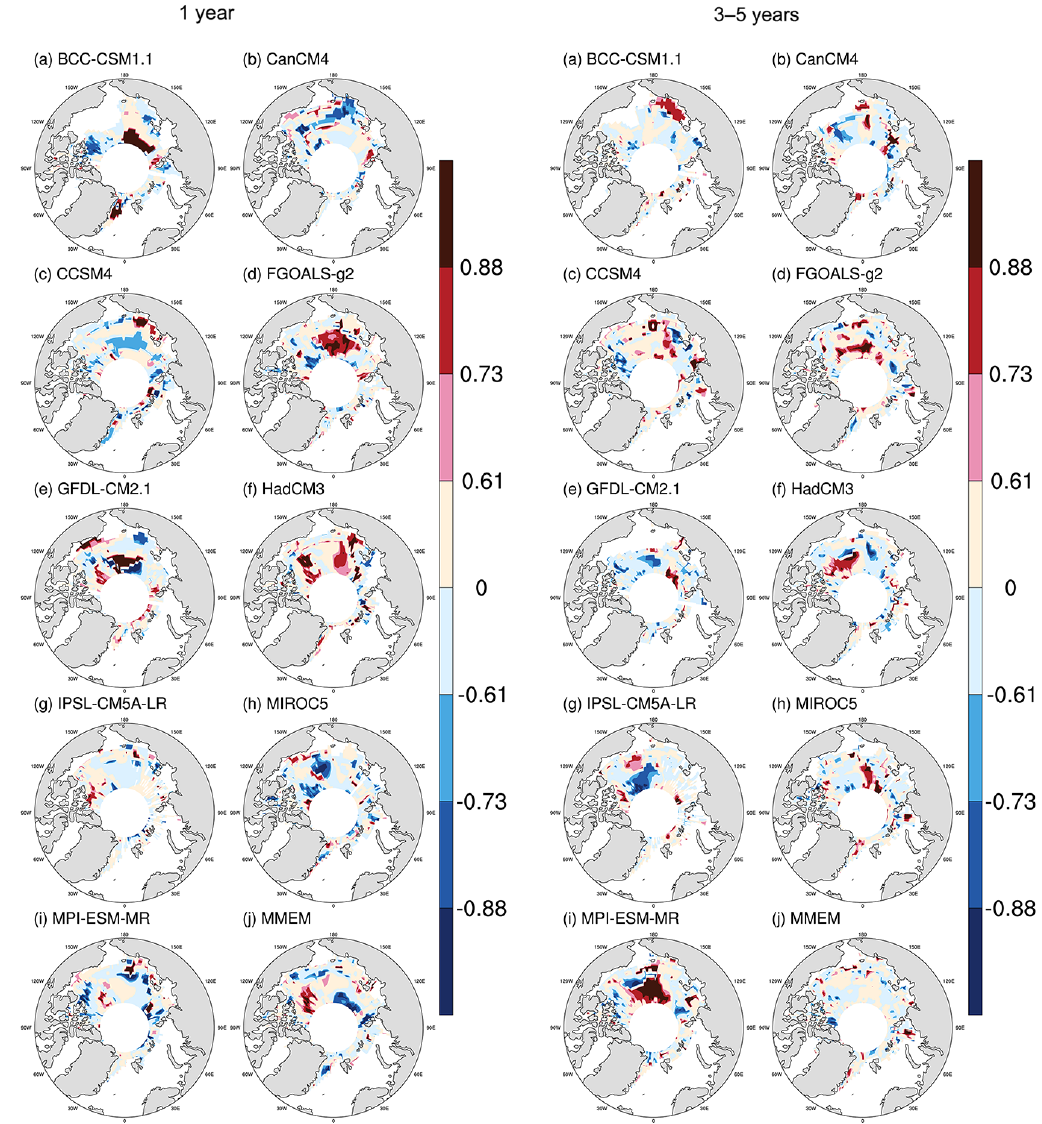
Figure 15. Same as Fig. 14 but for detrended September sea ice concentration